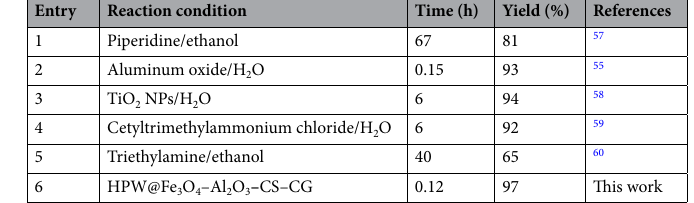
Table 4. Comparison of the catalytic activity of HPW@Fe 3 O 4 –Al 2 O 3 –CS–CG catalyst with reported results in the